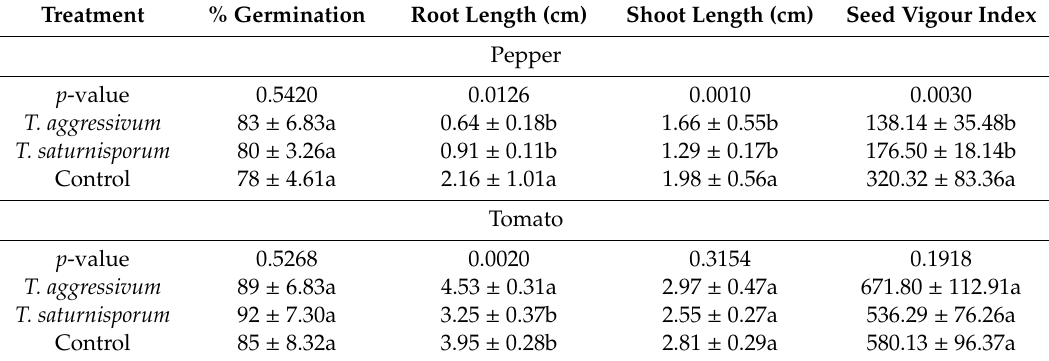
Table 3. Effects of T. aggressivum f. europaeum and T. saturnisporum on tomato and pepper seed germination 7 and 10 days after treatment, respectively.